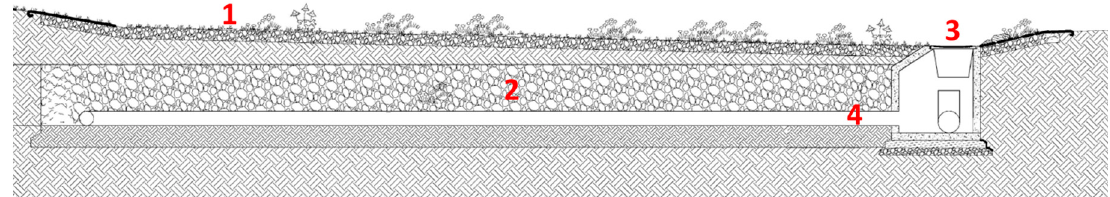
Figure 6. Typical cross section of a gravel swale in Waterway Ridges.